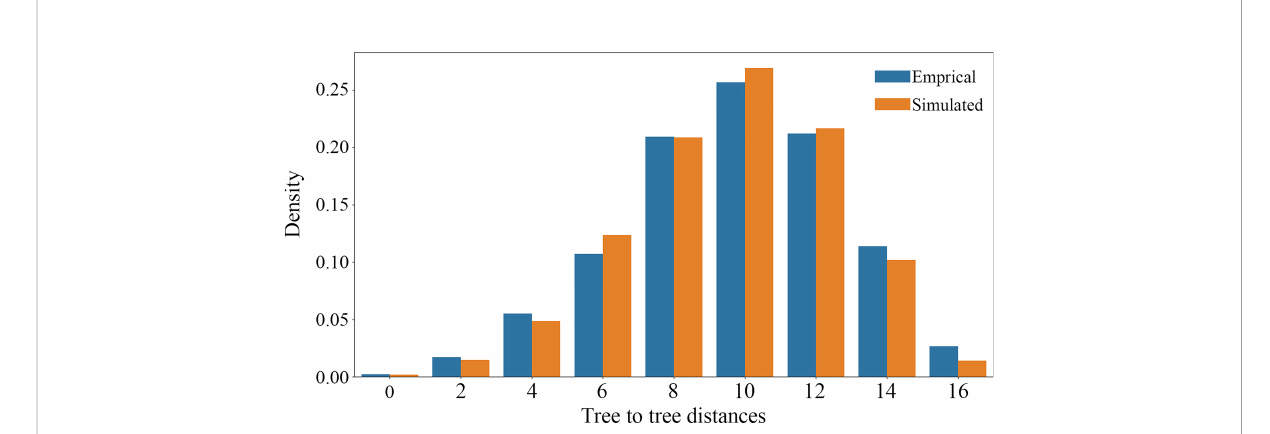
FIGURE 6 Coalescent simulations of tree-to-tree distance distributions between the ASTRAL species tree and the 4393 empirical (orange boxes) gene trees (based on trees from SCOG1000 dataset with average bootstrap value more than 60) and those from the 10,000 simulation trees (blue